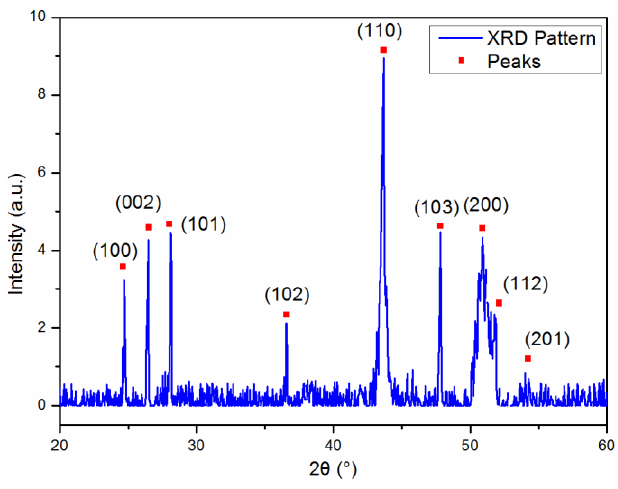
Figure 3. XRD pattern of the CdS nanobelt.